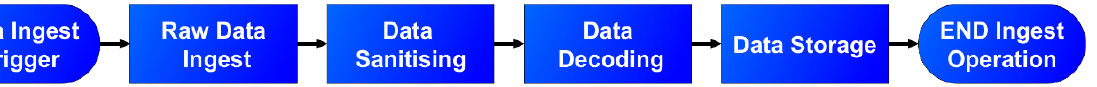
Figure 3. High-level flow diagram representing the behavior of the data integration and manage- ment system.